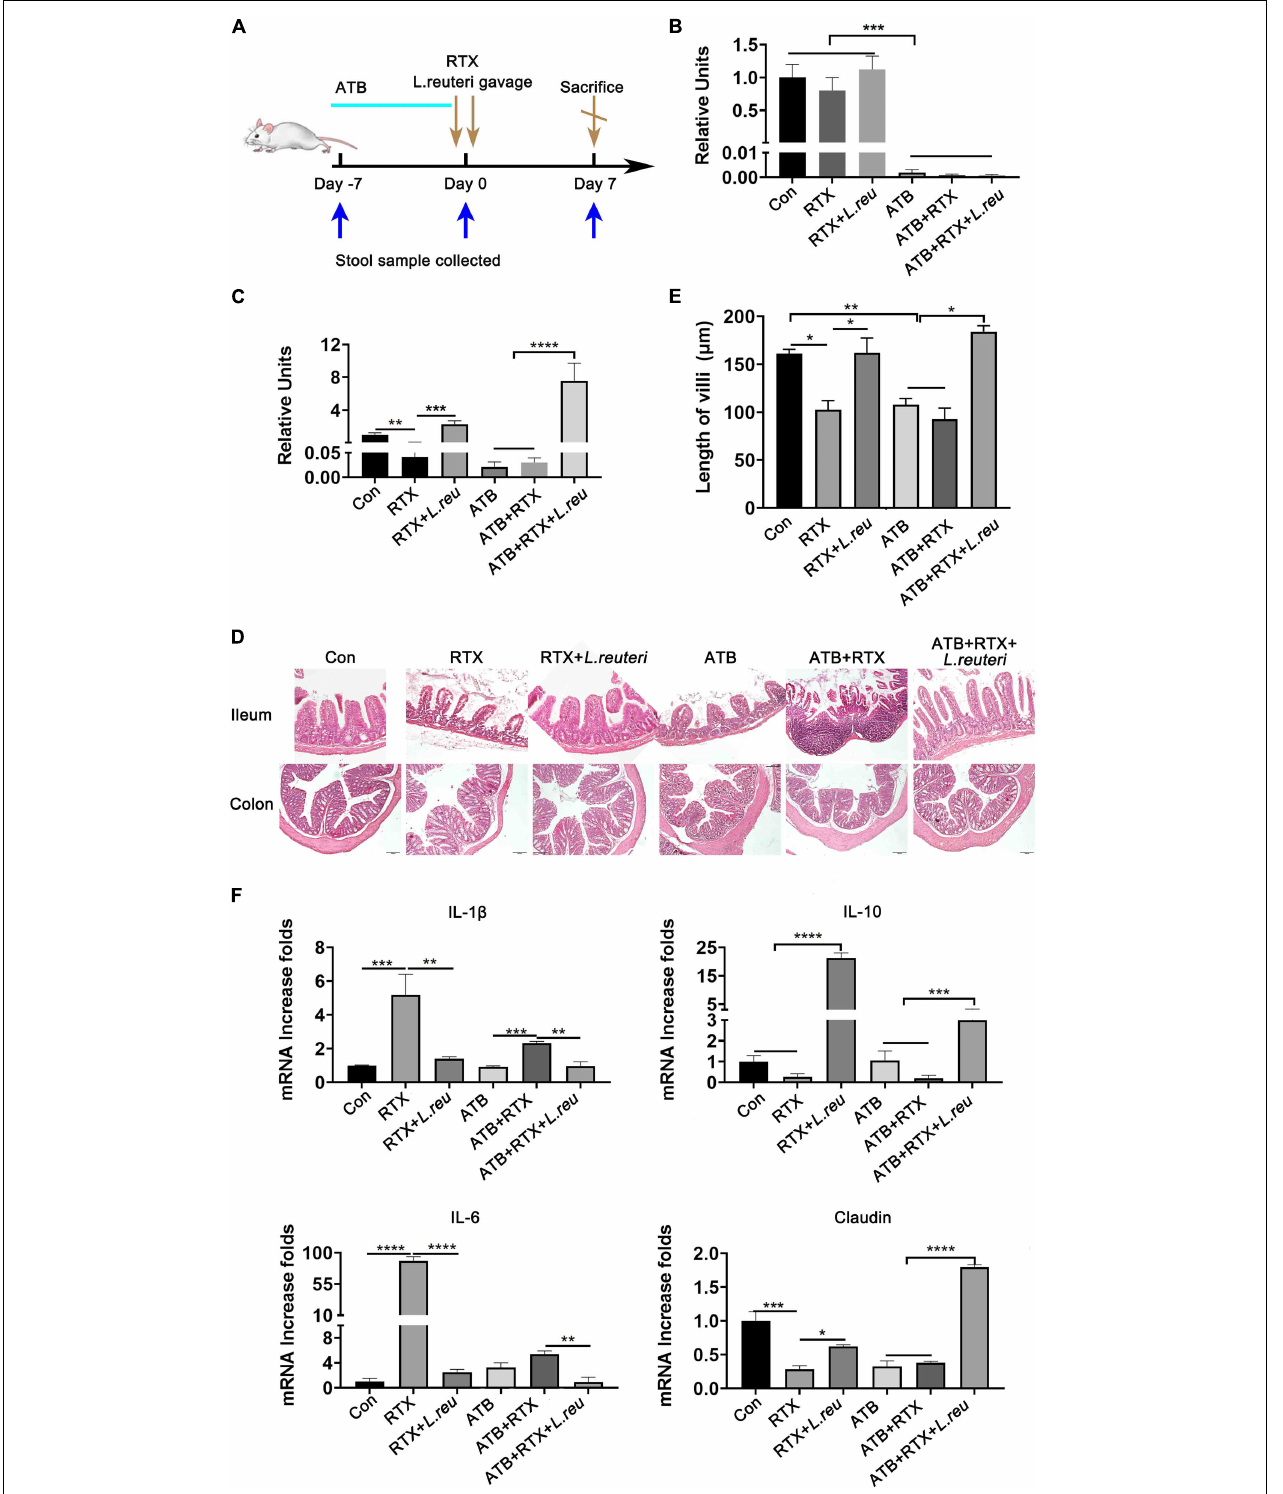
FIGURE 6 | Lactobacillus reuteri attenuates RTX-induced inflammatory injury. (A) Experimental schedule. (B) Relative abundance of L. reuteri in the intestine of mice detected by qPCR after 5 days of antibiotic administration. (C) Relative abundance of L. reuteri in the intestine detected by qPCR after 5 days of L. reuteri gavage. (D) H&E staining of the ileum and colon (magnification, 40 × ). (E) Villus length of the ileum. (F) mRNA expression levels of IL-1 β , IL-6, IL-10, and claudin in the ileum of mice. Data are expressed as the mean ± SEM. p < 0.05, ** p < 0.01, *** p < 0.001, **** P < 0.0001. Con, control; ATB, antibiotic treatment; L. reu , L. reuteri .